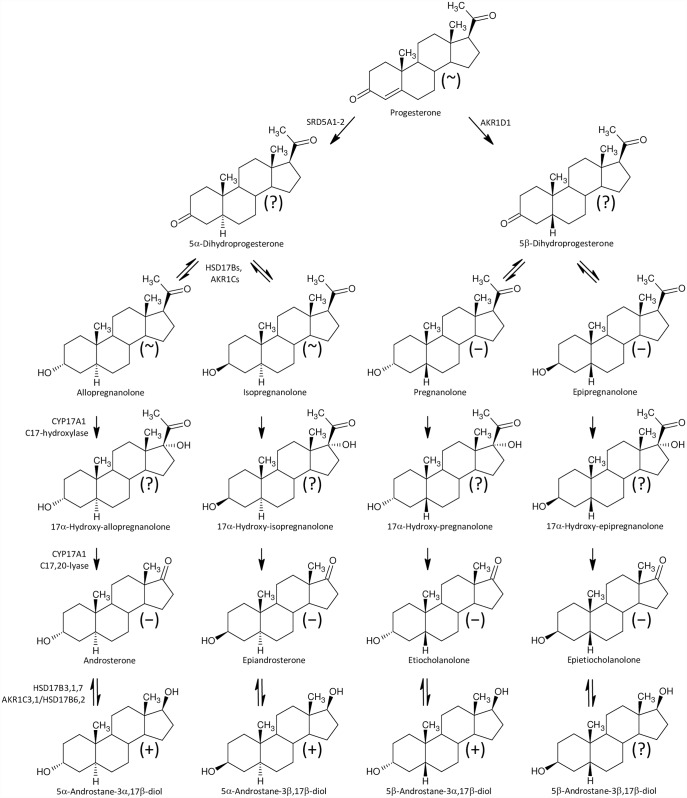
A simplified scheme of 5α/β-reduced C19 steroid biosynthesis in human, “backdoor pathway”.The symbols in parentheses “+”, “~”, ”−“, and ”?” represent increased, unchanged, decreased and unknown steroids levels, respectively, in the ICP group.